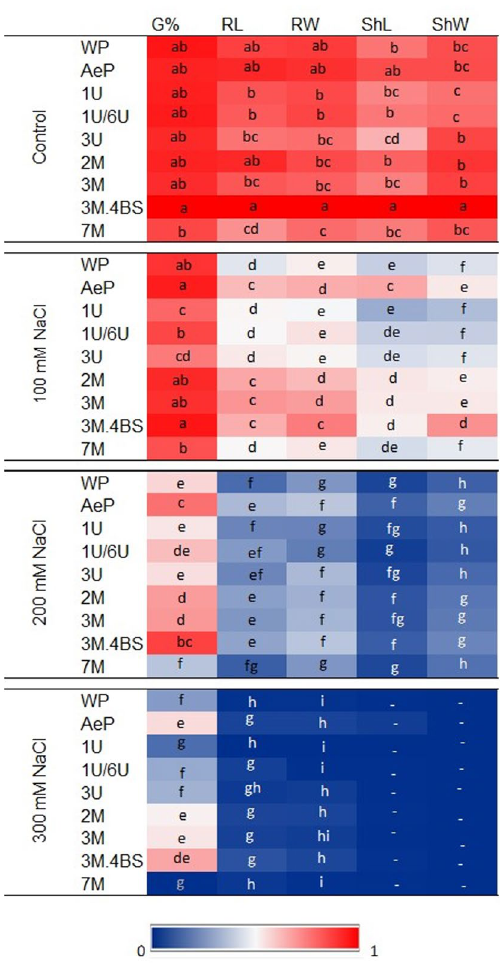
Figure 1. Comparison of germination properties (germination rate [G%], root length [RL], root weight [RW], shoot length [ShL], and shoot weight [ShW]) of seedlings of different addition lines and wheat (WP) and Aegilops (AeP) parental lines in the control (without salt treatment) and under salt stress conditions induced by 100, 200 and 300 mM NaCl treatment. Each parameter is scaled between 0 and 1 values, where dark blue represents the lowest value (0) and intense red represents the highest value (1). The absolute values are found in Supplementary Table